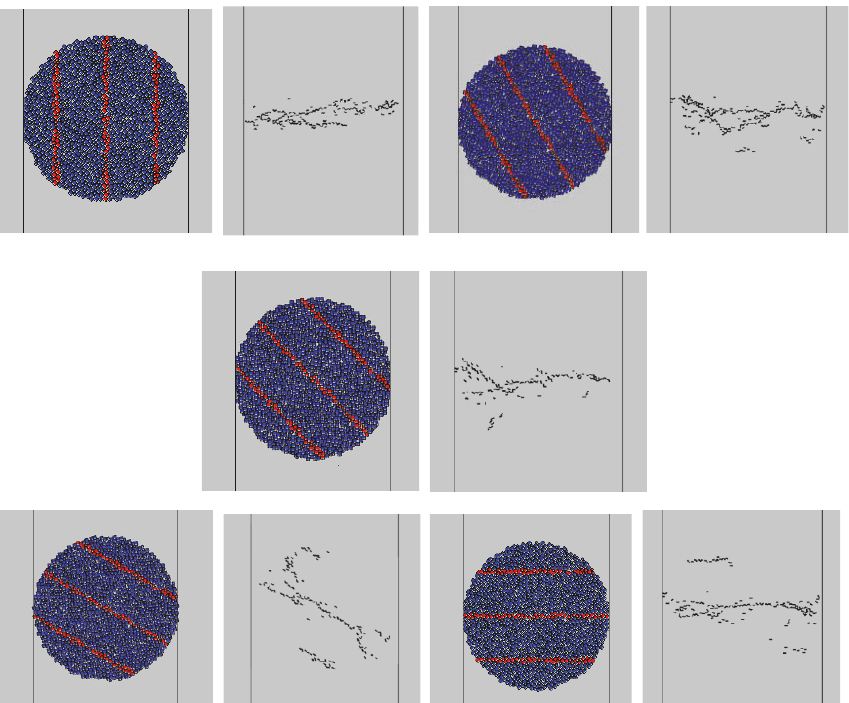
Figure 12: Different crack propagation characteristics of shale with different bedding plane angles (the loading direction is vertical).